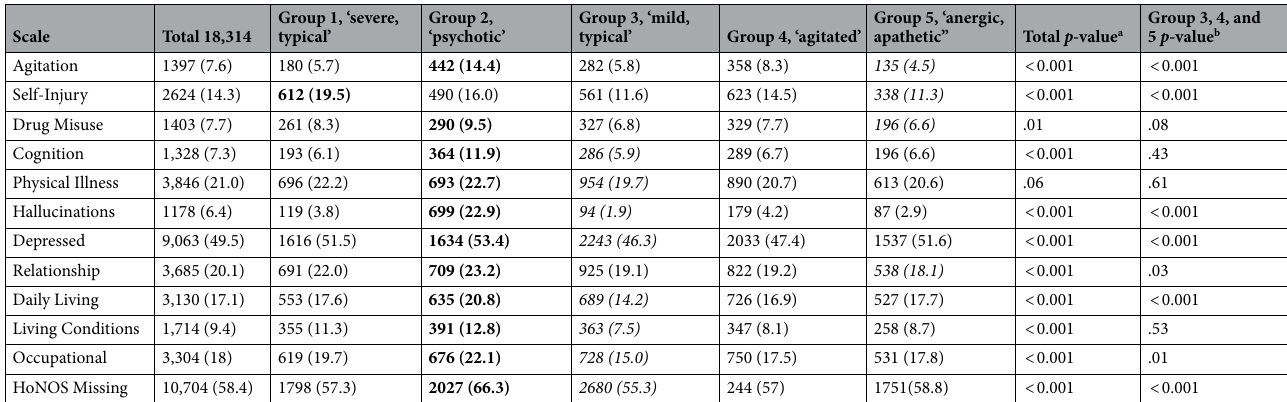
Table 3. Prevalence of HoNOS problems compared by depression sub-group. a Chi-squared test with 4 degrees of freedom. b Chi-squared test with 2 degrees of freedom. Groups with the highest likelihood of problems are presented in bold font and the lowest likelihood in italicized